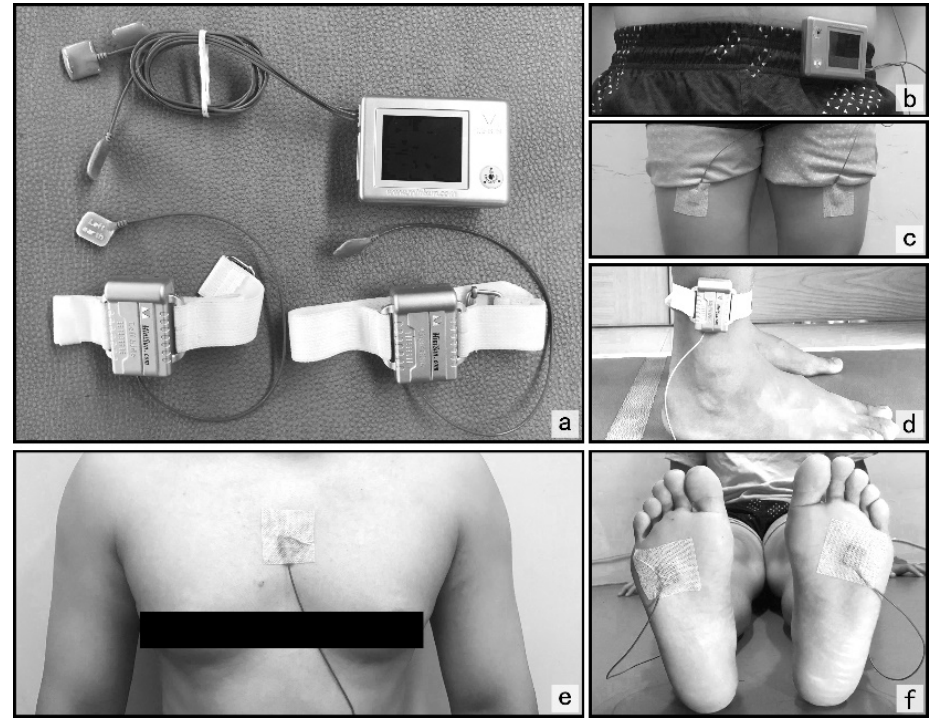
Figure 1. Outline of procedures. Schemes follow the same formatting. ( a ) Intelligent Device for Energy Expenditure and Activity (IDEEA); ( b ) main recorder position; ( c ) thigh sensor position; ( d ) secondary recorder’s position; ( e ) sternal sensor location; ( f ) foot sensor position.